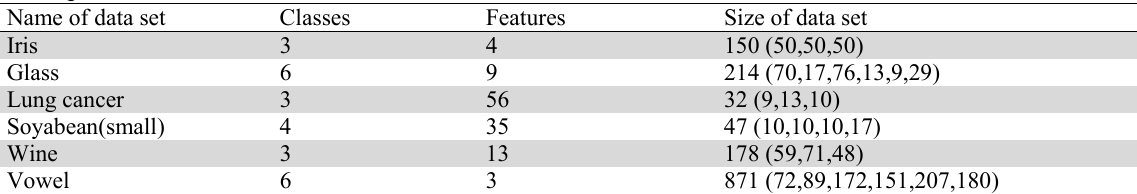
Description of data